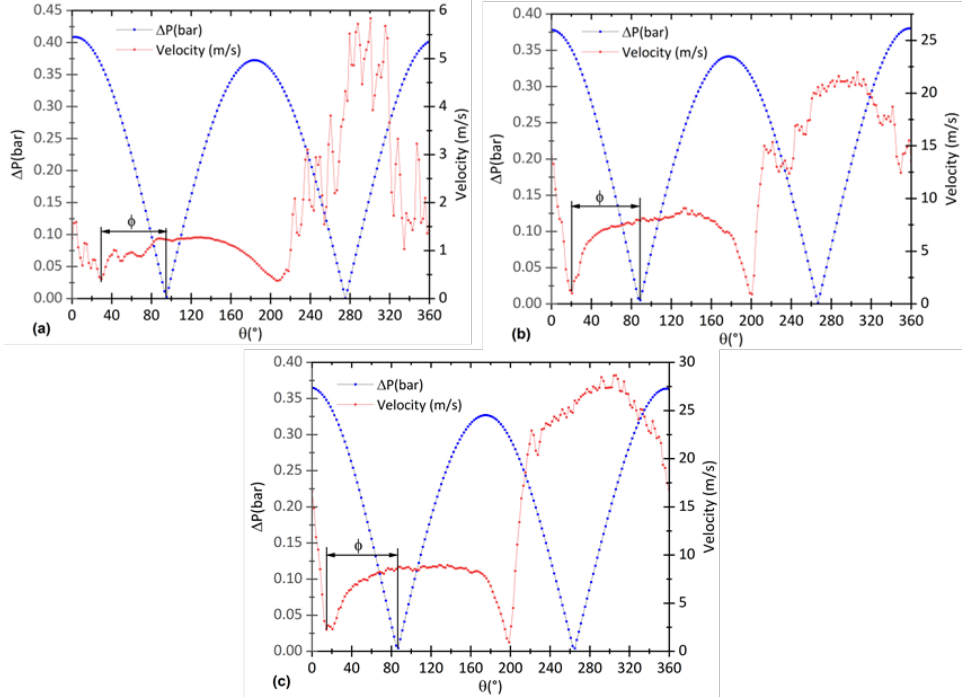
Figure 14. Evolution of the pressure drop ∆ P and the velocity u as a function of the angle of rotation θ of a regenerator (( a ): Str_30%, ( b ): Str_35%, ( c ): Str_40%. L 1 = 60 mm, C 1 = 64.4 mm) versus the phase for the temperature gradient ∆ T 1 = 70 ◦ C/10 ◦ C.